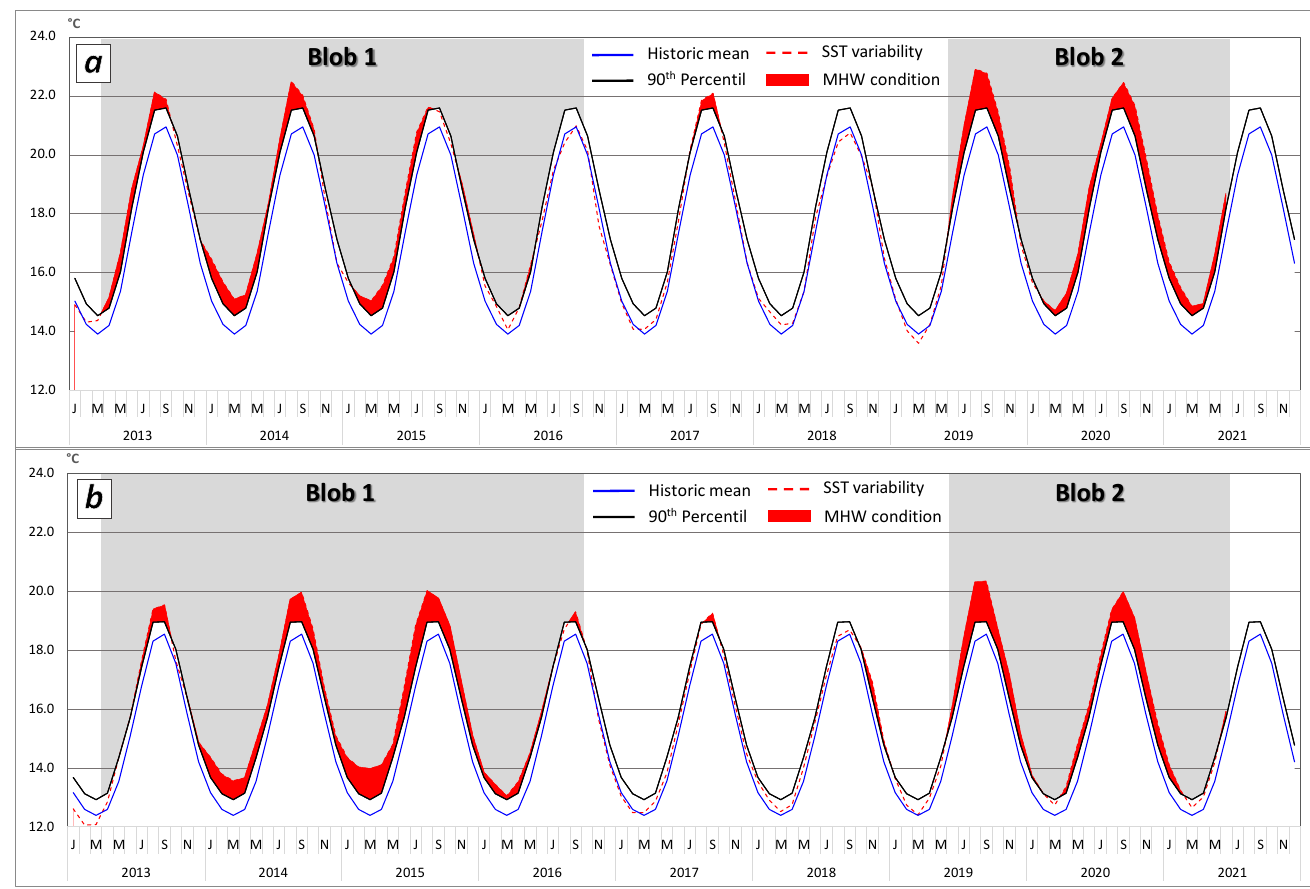
Figure 11. Marine heatwave (MHW) dynamics from January 2013 to June 2021 at: ( a ) the PAC-NE oceanic region (from Thielen et al. [13]) and ( b ) the region NEP — Northeast Pacific SST index (from CPC/NCEP/NOAA [39]) (see Figure 2). Solid blue line represents the historic mean SST for the climatological series January 1982 — December 2011. As for the solid black line, it represents the 90th percentile, while the dashed red line represents the observed monthly SST variability. Red areas represent the moments when MHW condition has been reached (i.e., SSTA > 90th percentile). As for intensity, the thicker the resulting (red) area, the more intense the MHW. Grey areas are relative to the occurrence of Blob 1 and Blob 2.